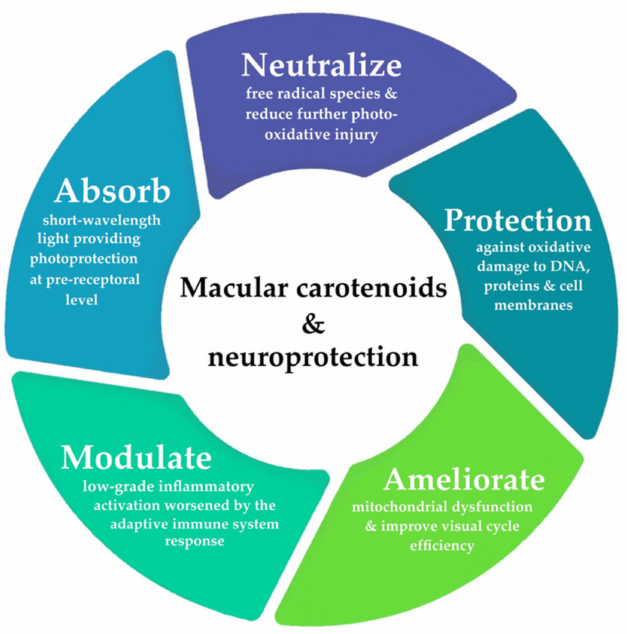
Figure 1. Overview of the neuroprotective mechanisms of xanthophylls lutein, zeaxanthin, and meso -zeaxanthin in the central retina.